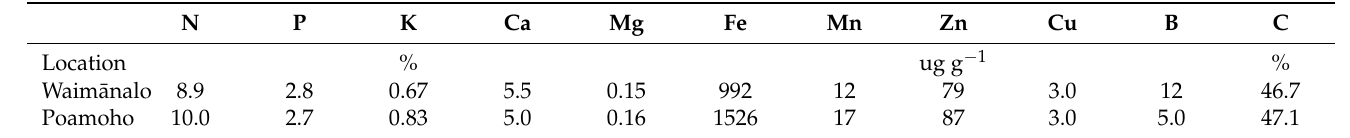
Table 2. Nutrient analyses from meat and bone meal fertilizer z used in field